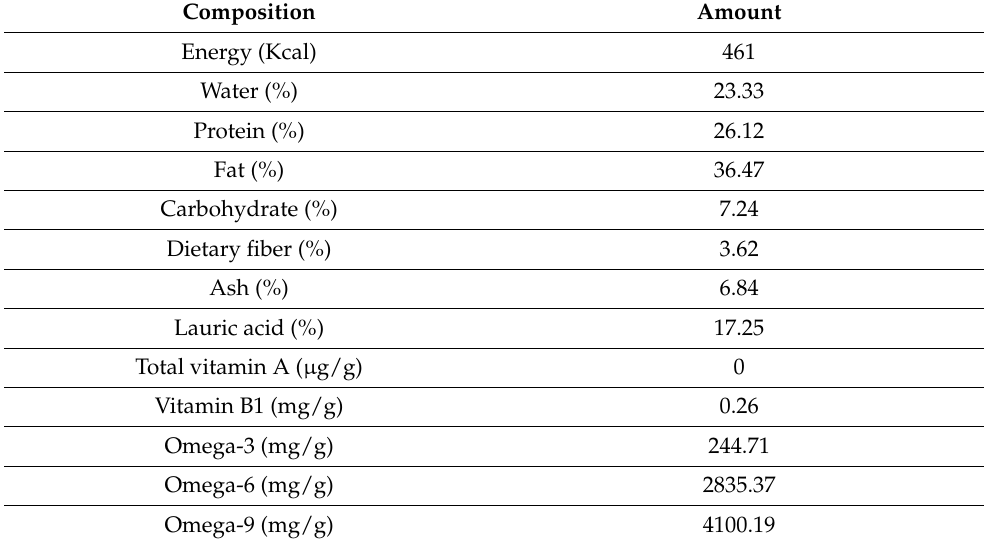
Table 2. Composition of